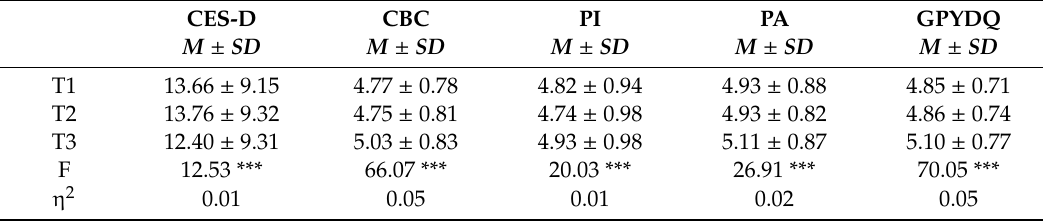
Table 3. Repeated measures related to depressive symptoms and